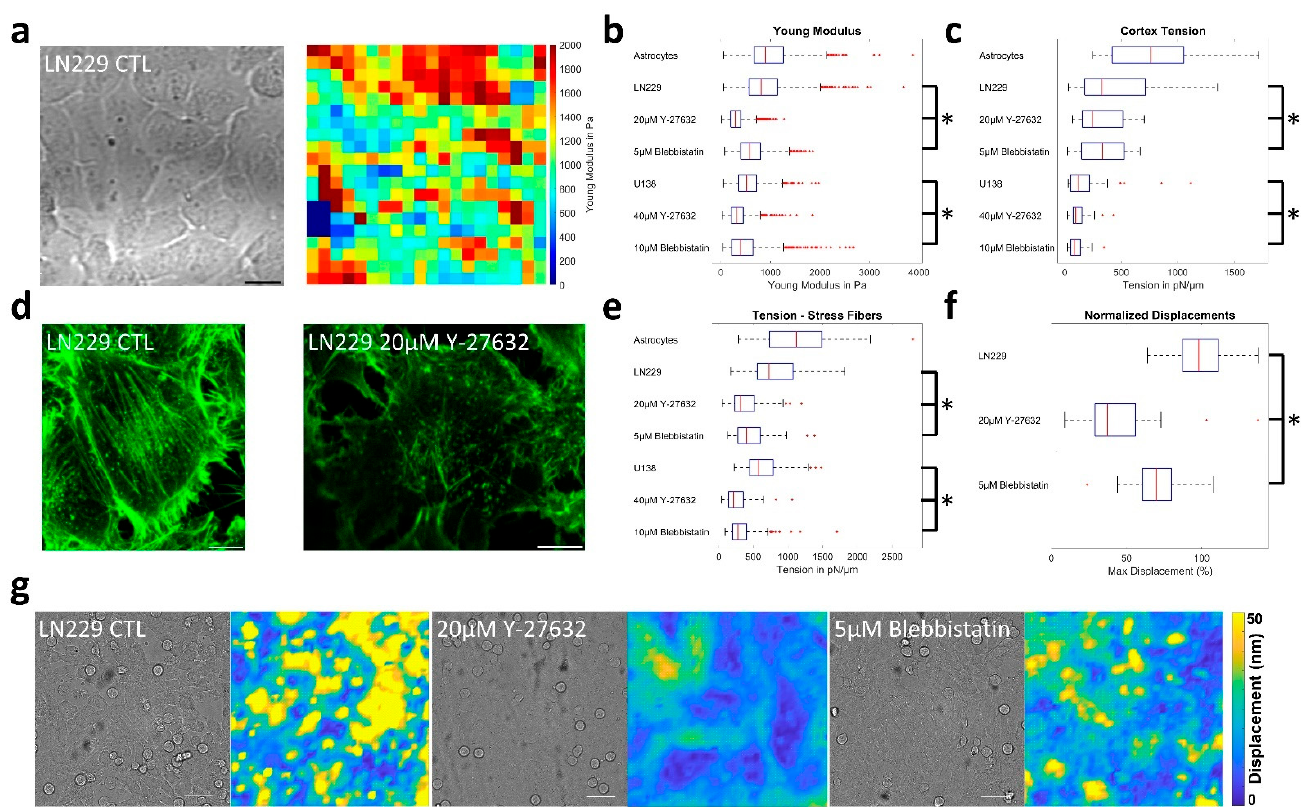
Figure 6. Biomechanical properties of astrocytes and glioblastoma cells. ( a ) Illustration of a typical 140 × 140 µ m 2 dense layer of LN229 cells used for measuring elastic moduli (left) and the respective map of the elastic moduli (right). Scale bar represents 20 µ m. ( b ) Measurements of the Young moduli for astrocytes and both GBM cell lines, when treated with the ROCK inhibitor Y-27632 or myosin II inhibitor blebbistatin. p < 0.0001 for all significant results, as assessed by one way ANOVA with Tukey post hoc test. For astrocytes 1187 sample curves were obtained. For LN229 1568, 1566 or 1585 and for U138 cells, 1161, 1164 or 1148 measurement curves were evaluated for control conditions, Y-27632 or blebbistatin treatment, respectively. ( c ) Cortical tension of astrocytes, LN229 and U138 cells, when subjected to ROCK or myosin II inhibition. p < 0.05 for all LN229 measurements and U138 control conditions vs. 10 µ M blebbistatin. p < 0.01 for U138 vs. 40 µ M Y-27632. One way ANOVA with Tukey post hoc test was used. For astrocytes, 45 cells were measured. For LN229, 55, 55 or 53 and for U138, 55, 53 or 54 cells were measured for control conditions or when treated with Y-27632 or blebbistatin, respectively. ( d ) A typical actin staining of LN229 cells in control conditions (left) and when treated with 20 µ M of Y-27632 is shown. Scale bars depict 10 µ m. ( e ) Estimation of the tension generated by stress fibers by astrocytes and GBM cell lines. 75 cells in 15 fields of view were analyzed in each group. p < 0.0001 for all significantly different treatments, as assessed by one way ANOVA with Tukey post hoc test. ( f ) Normalized bead displacements obtained from the TFM measurements for LN229 cells. p < 0.0001 for all significantly different treatments. ( g ) Sample images and the respective displacement maps for (un-)treated LN229 cells. Scale bars depict 50 µ m. ( b , c , e , f ) Box plots show the median (red line), 25 and 75 percentile (box), non-outlier range (whiskers) and outliers (red dots). Stars (*) depict statistically significant